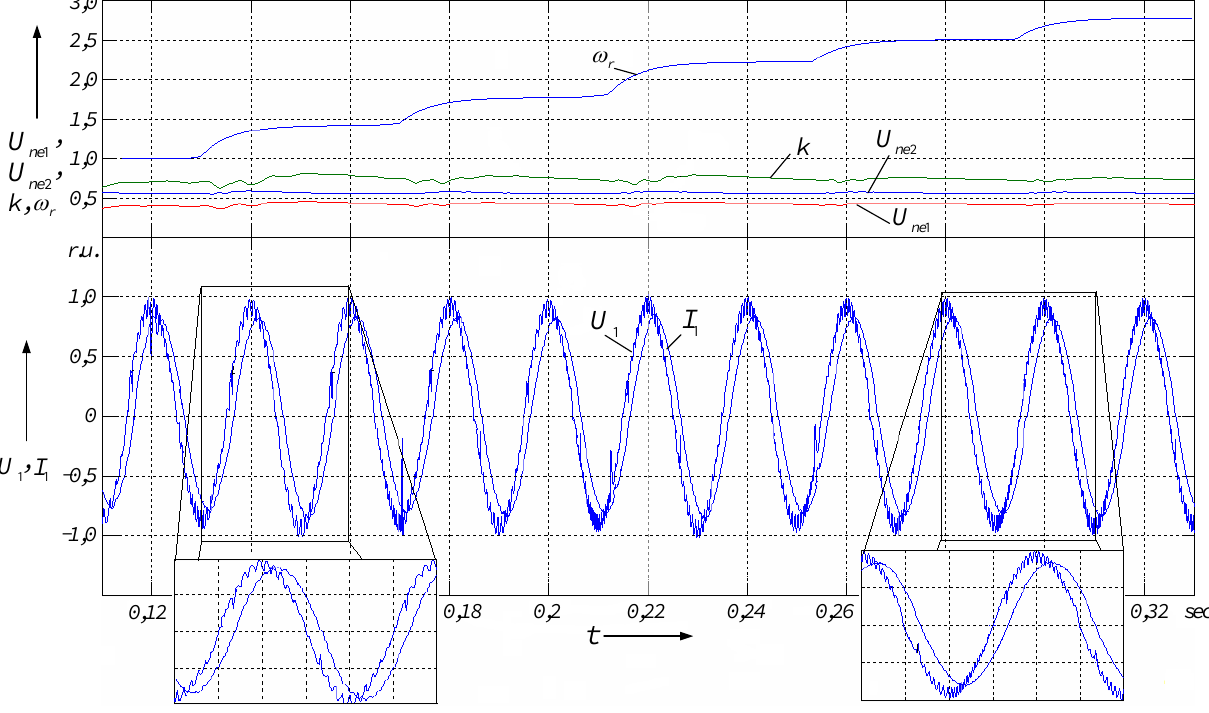
Figure 12. Load voltage and current waveforms of MCS when changing rotational speed of driving shaft while stabilizing output electrical parameters of MCS by means of DC and AC excitation winding